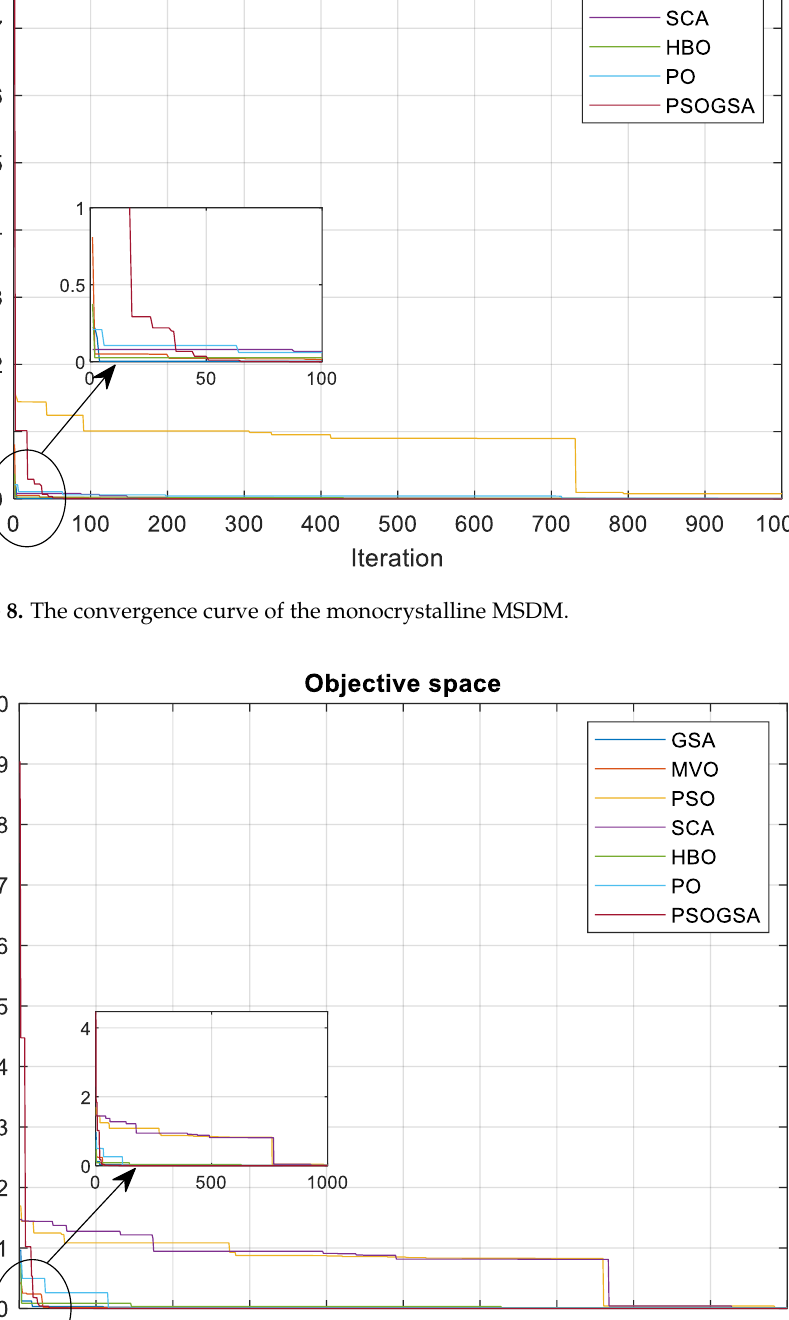
Table 6. The monocrystalline MDDM parameter estimation results.